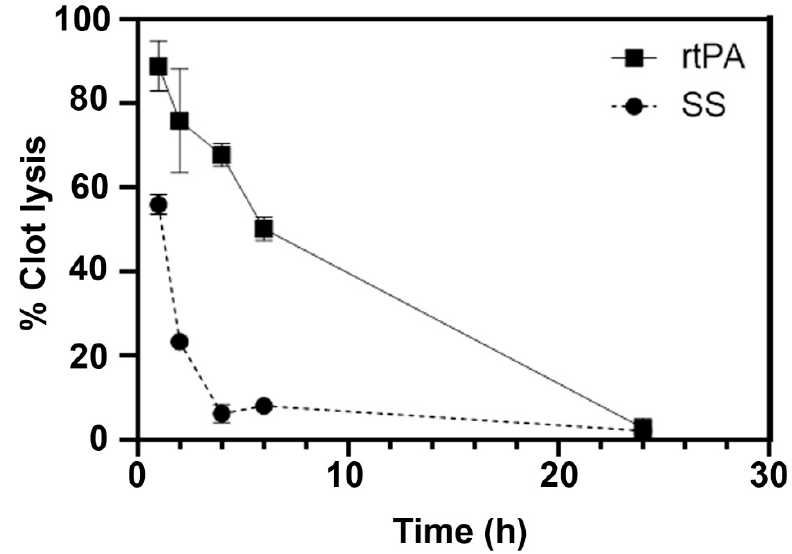
Figure 3. Percentage of in vitro clot lysis upon addition of rtPA or saline solution (SS) at 37 °C.